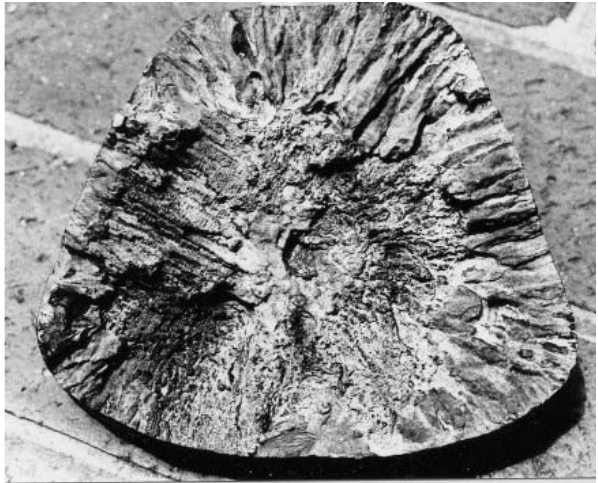
Figure 4: Example of brittle intergranular (rock candy) fracture during fatigue loading in cast steel. The particular example shown is due to aluminium nitride